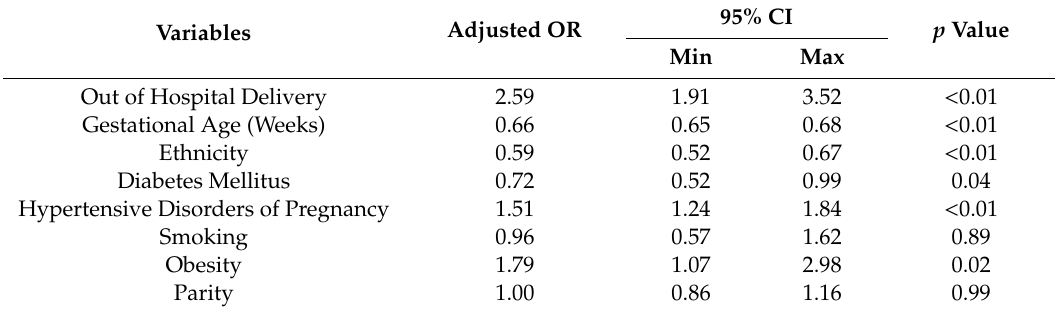
Table 3. Multivariable generalized estimating equation (GEE) analysis for perinatal mortality outcome.